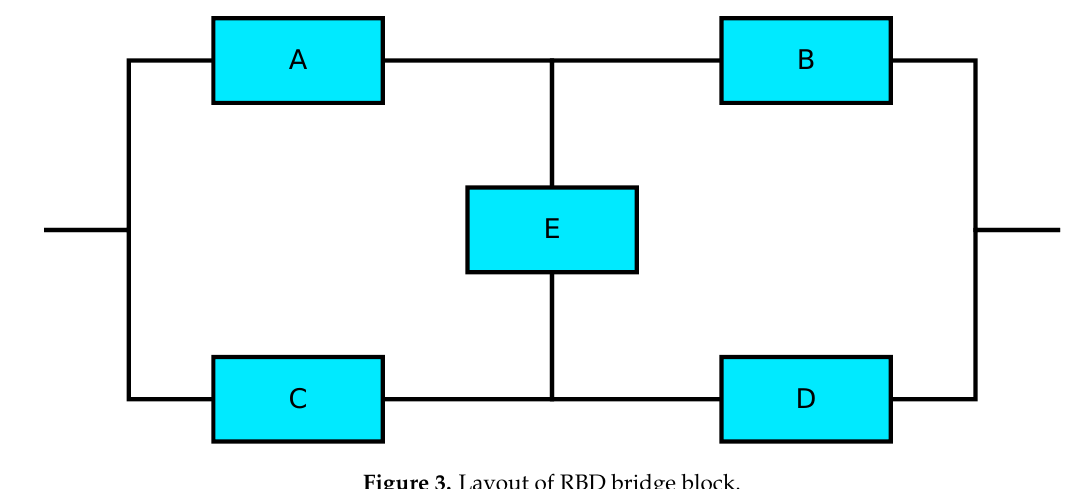
Figure 3. Layout of RBD bridge